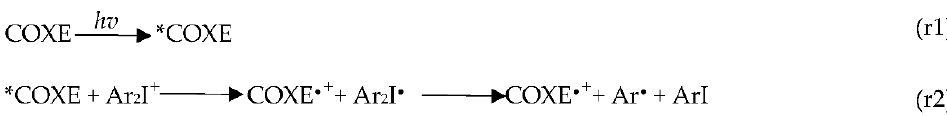
Figure 11. C=C double bond conversion–time curves obtained for TPGDA polymerization initiated by ( a ) COXEs, ( b ) BCIM/NPG/COXE, and ( c ) NPG/COXEs under 450 nm LED irradiation (photo intensity: 100 mW · cm − 2 ). The COXE concentration was 2.4 × 10 − 6 mol · g − 1 and the concentrations of BCIM and NPG were 7.2 × 10 − 6 mol · g − 1 .